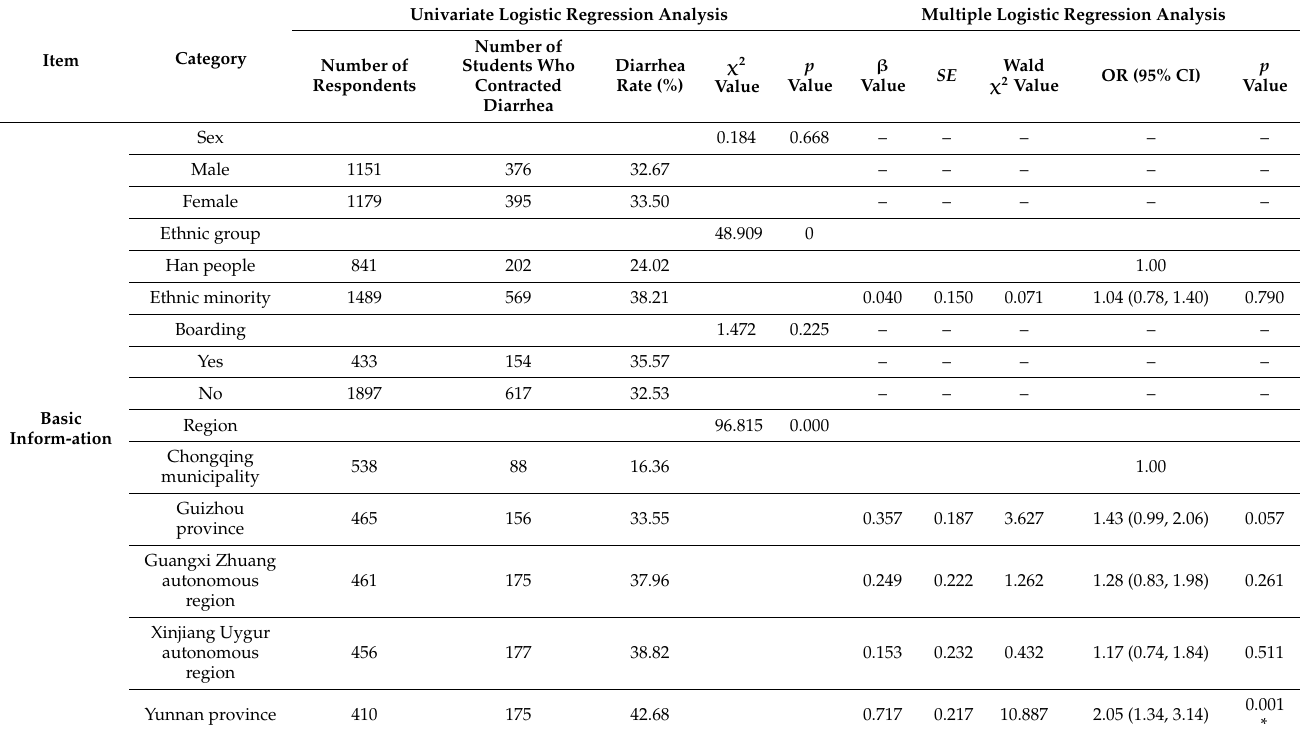
Table 2. Univariate and multiple logistic regression analysis of factors associated with the risk of contracting diarrhea.